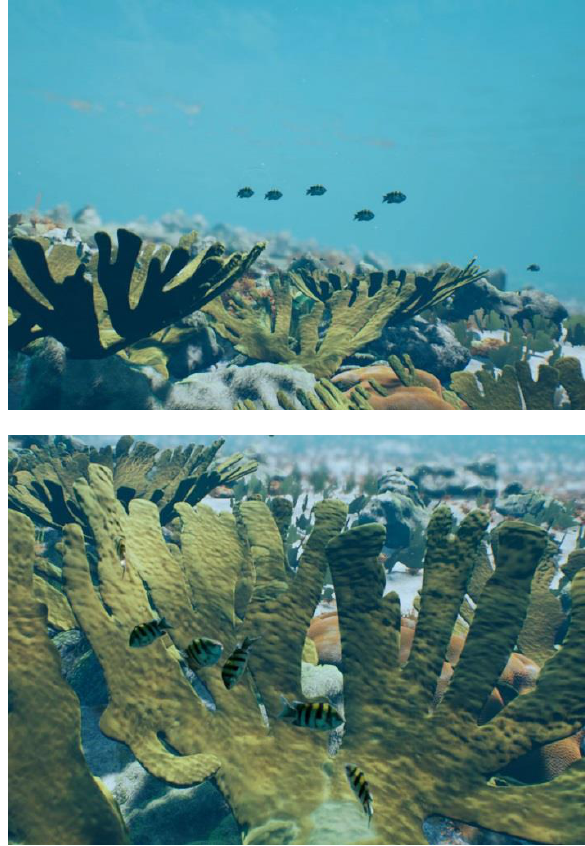
Figure 5. Collective movement of agents in a GeoIVE of a submarine ecosystem. Regular (above) and irregular (below) motion patterns produced by the rules of (1) collision avoidance, (2) polarization, (3) aggregation and (4) self-organized